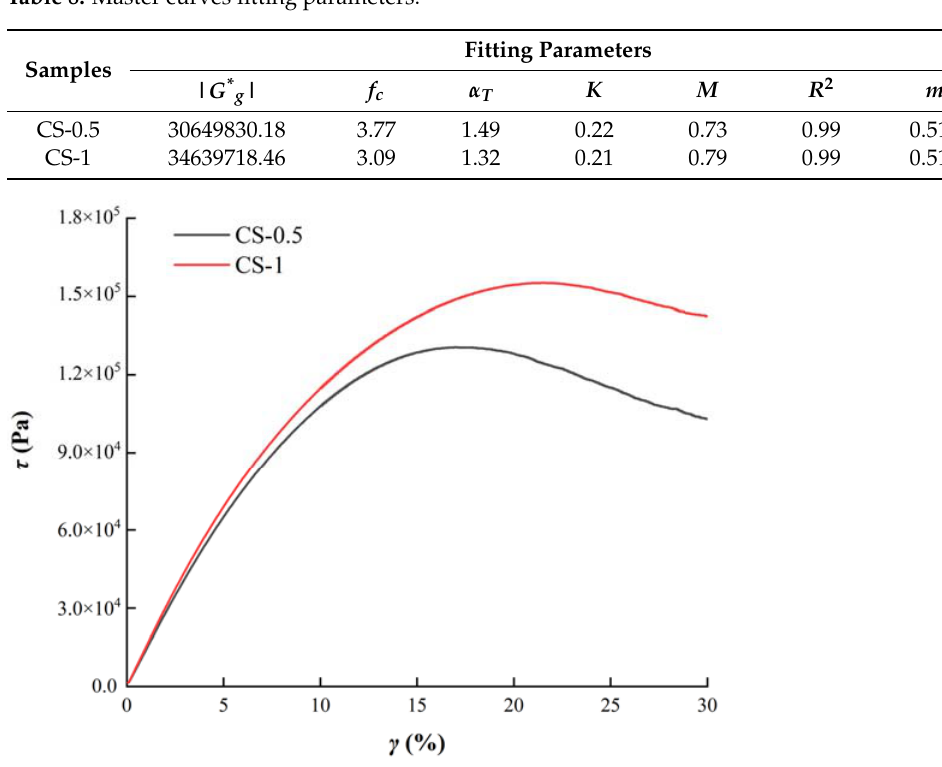
Figure 9. Master curves ( a ) CS ‐ 0.5 and ( b ) CS ‐ 1.